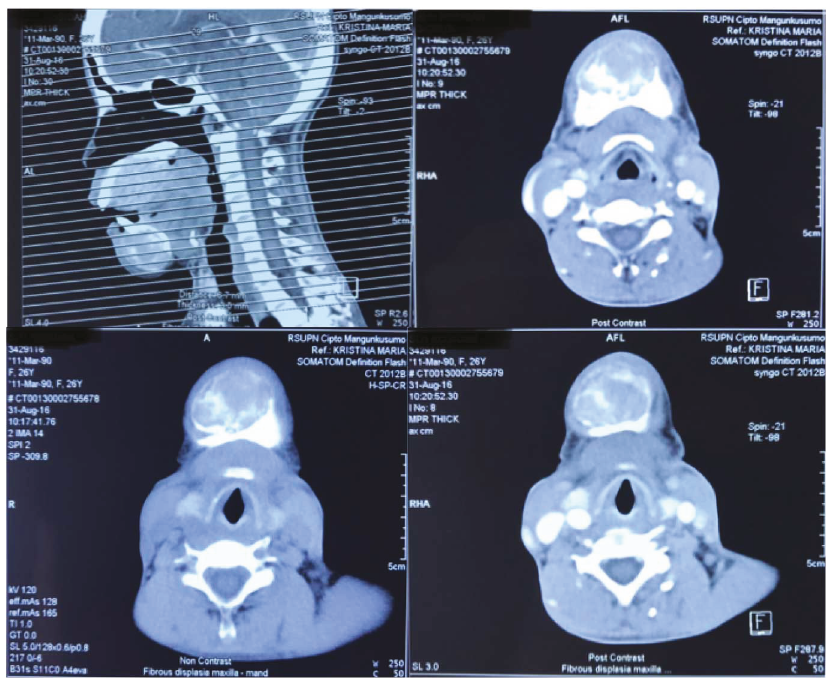
Figure 4: Case 1. Paranasal CT scan. Decreased di ff use with ground glass appearance among the cranium, facial, and cervicothoracic bones. Multiple lytic lesion in the maxillary